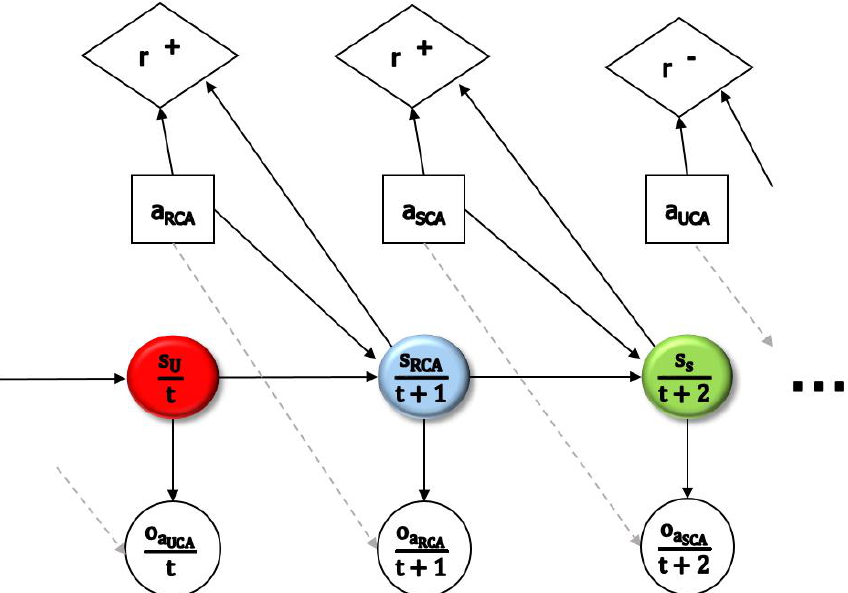
Figure 2. A state transition automaton for the proposed Markov decision process